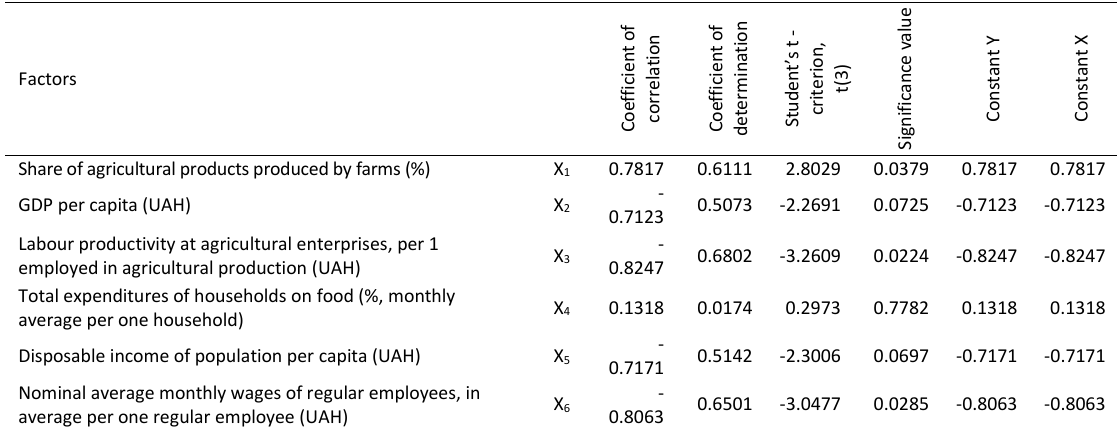
Table 8: Analysis of the level of economic factors’ impact on the volumes of animal husbandry production in Ukraine (correlation matrix) (State Statistics Service of Ukraine, 2018b; State Statistics Service of Ukraine, 2018f; State Statistics Service of Ukraine, 2018d; State Statistics